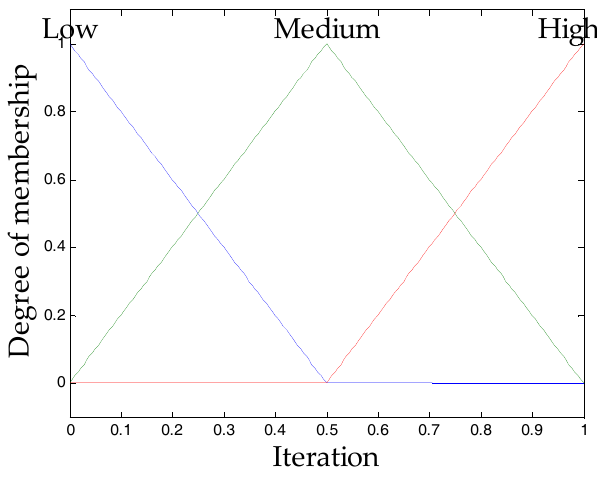
Figure 2. Input 1: Iteration.